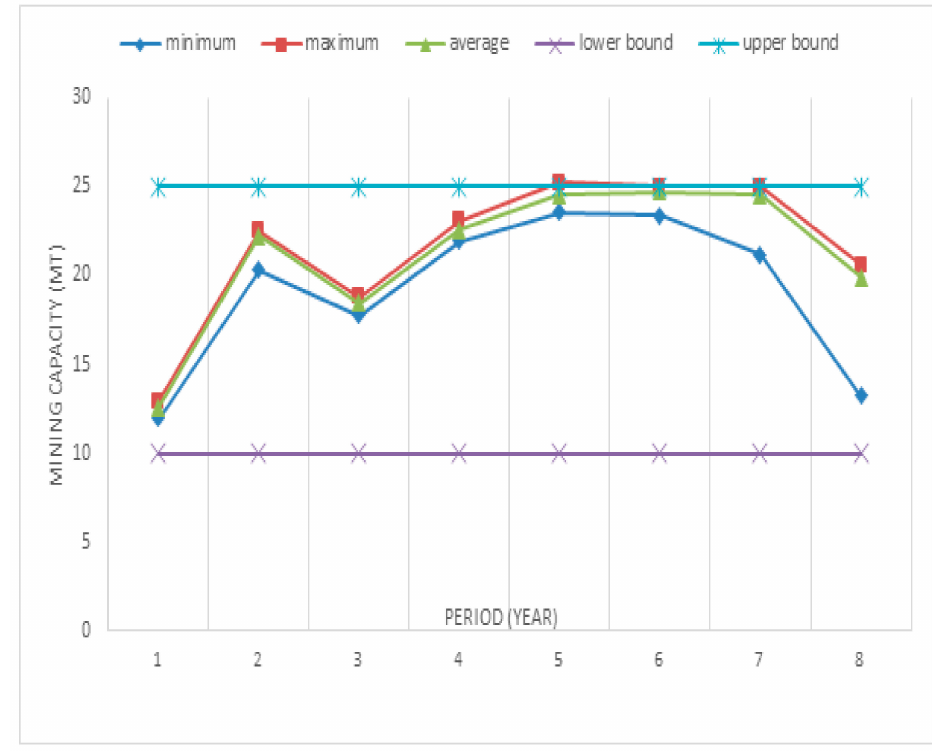
Figure 8. Mining capacity for production